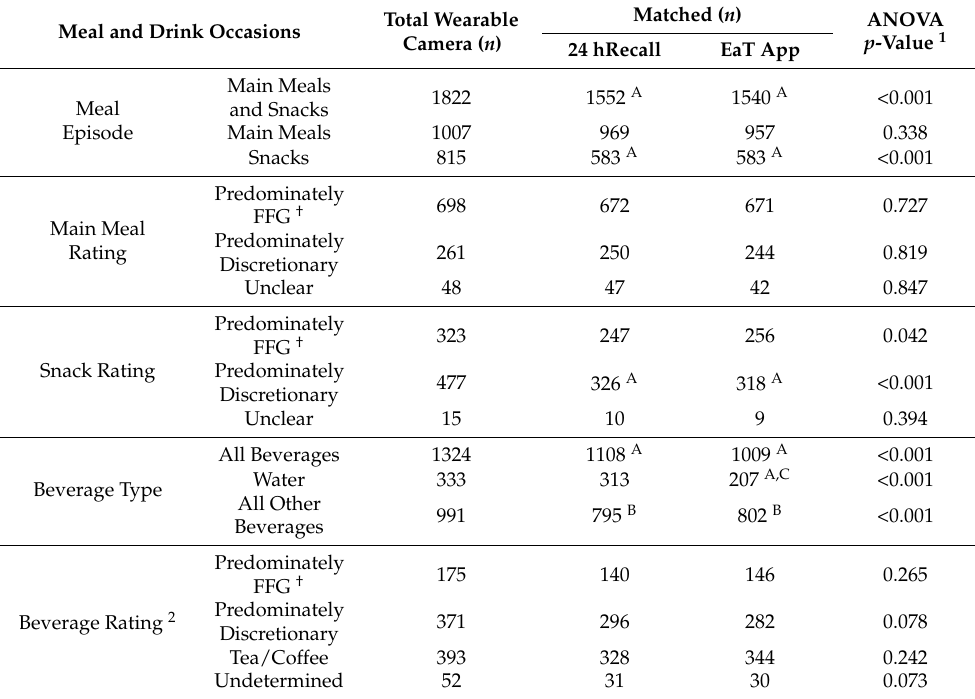
Table 2. Number of meal and drink occasions (total and matched) over three study days as assessed by 24 h recall and app compared to meals and drinks assessed using a wearable